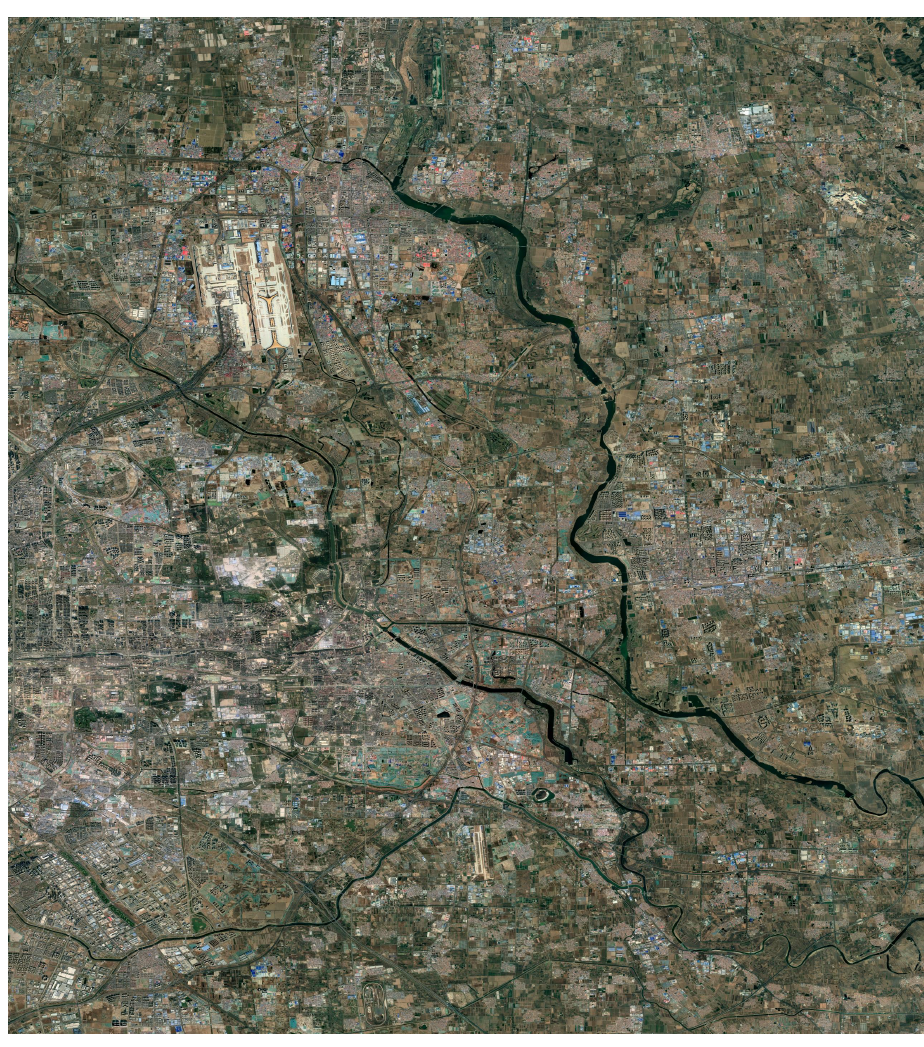
Figure A2. The Google Earth image of the study